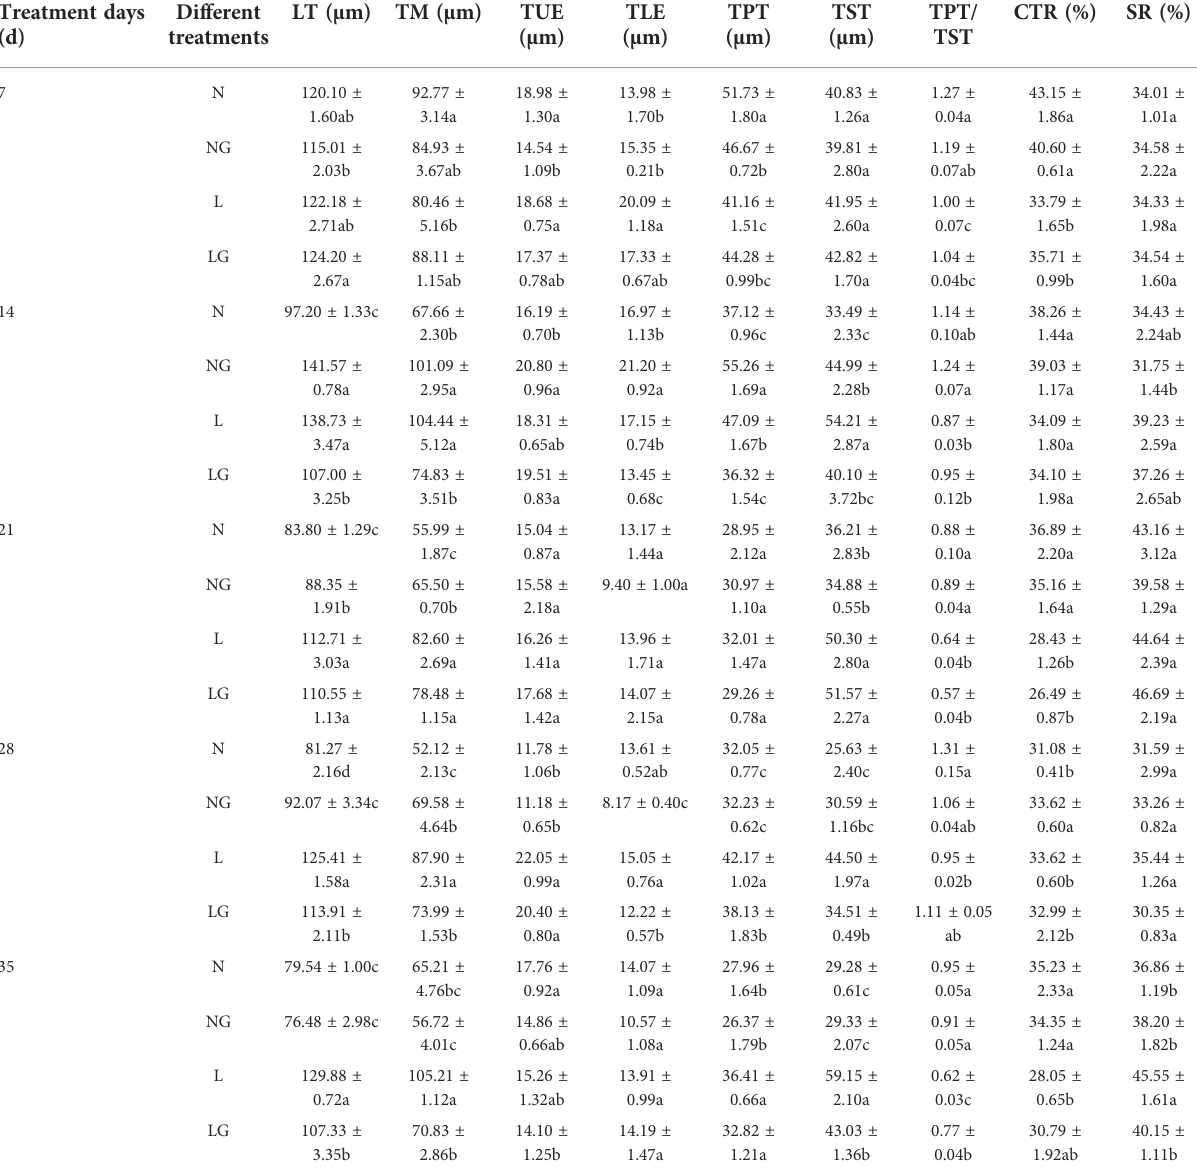
TABLE 2 Effects of GABA spraying on the anatomical structure of leaves of seedlings at low temperatures. Treatment days